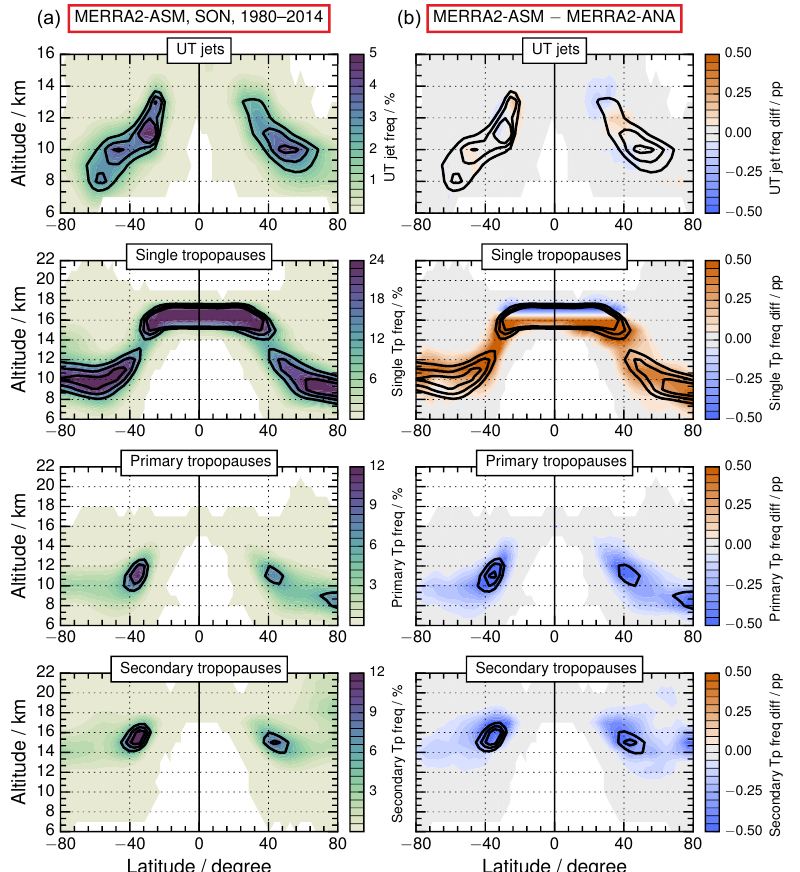
Figure 2. Seasonal cross sections for SON in 1980 through 2014 of MERRA-2 frequency distributions from ASM (a) and the difference between ANA and ASM (b) . The rows show (top to bottom) the upper tropospheric jet frequency, single tropopause frequency, frequency of primary multiple tropopause, and frequency of secondary multiple tropopause. Overlaid contours highlight the ASM distributions on the left (a) and ANA distributions on the right (b) . Frequencies are normalized as described in Sect. 2.3. Overlaid contours show frequency values from each reanalysis of 2, 3, and 4% for upper tropospheric jets and 12, 18, and 24% for multiple tropopauses; the smallest value is always the largest or “outermost” contour. In the difference plots, blues/oranges indicate negative/positive